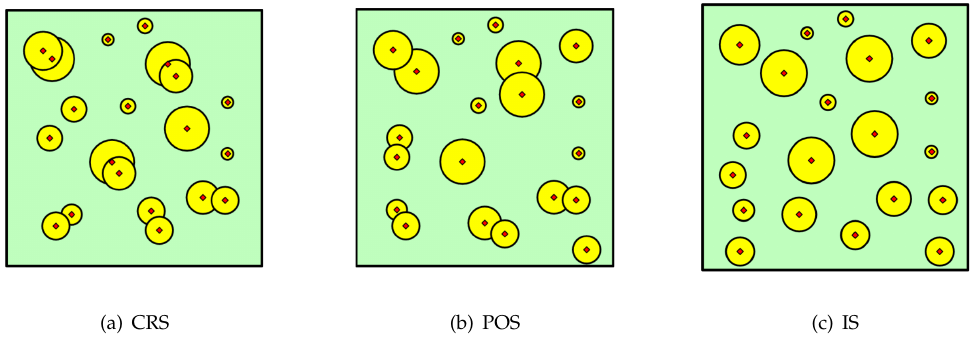
Figure 2. 2D illustrations for the relative position of pores of the three distribution modes. ( a ) Completely random selection, ( b ) partially overlapping selection, ( c ) isolated